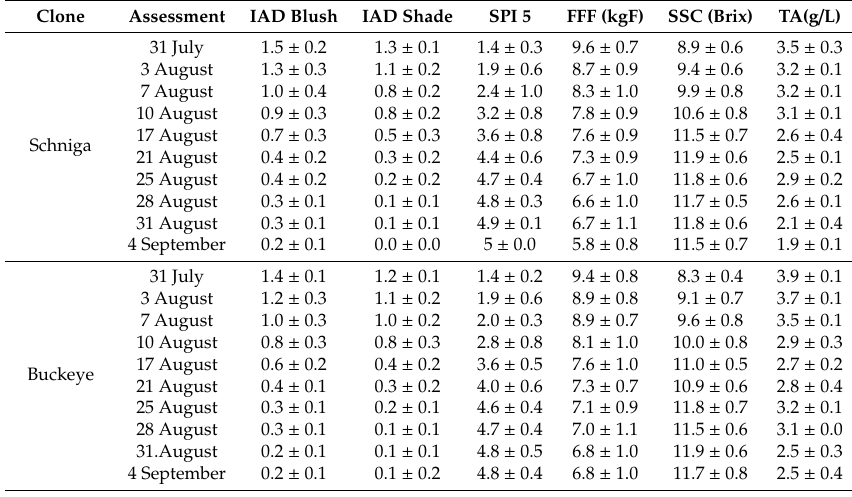
Table A2. Changes of IAD on blush and shade side of each fruit and standard maturity parameters (mean and standard deviation) in cv. ‘Gala’ apples during ripening in season